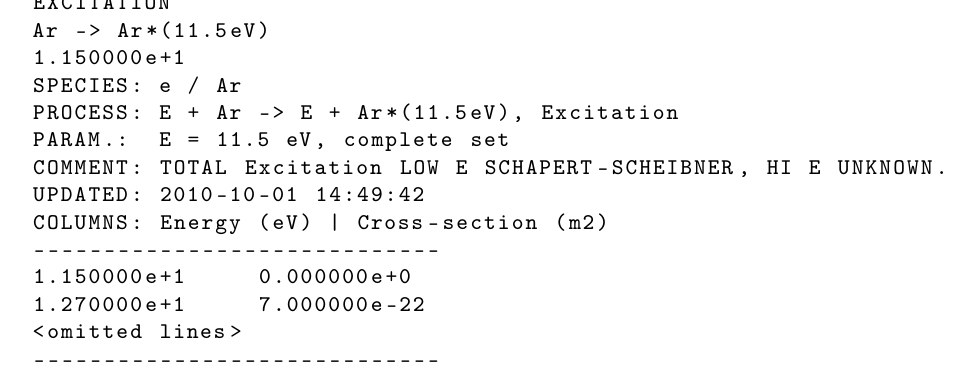
Figure 12. The argon excitation cross-section from the Phelps database [112]